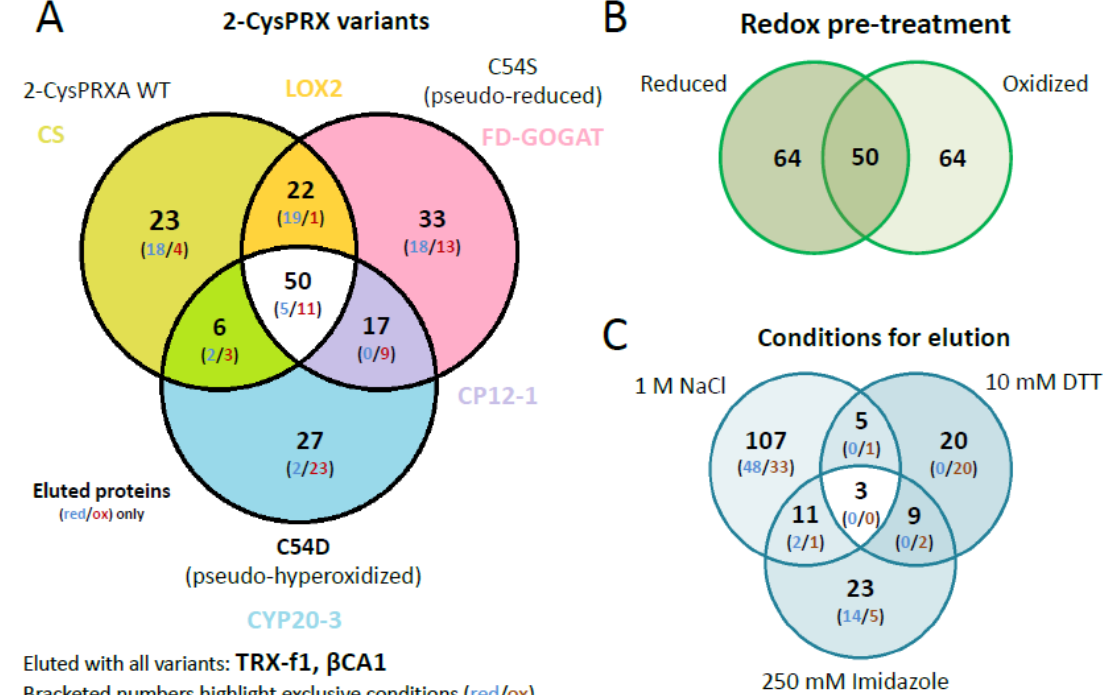
Figure 3. Venn diagrams depicting overlapping and unique 2-CysPRX interactors. ( A ) Comparison of the entire group of interactors of each variant. The set binding to all variants comprised 50 proteins of 178. The group of unique binders to WT, C54S, and C54D consisted of 23, 33, and 27 polypeptides, respectively. ( B ) The compiled groups of redox-specific interactions comprised 64 polypeptides binding under reducing and oxidizing conditions each, and 50 polypeptides binding under both conditions. ( C ) Comparison of the proteins eluted with high salt (NaCl), under reducing conditions (DTT) and as complex with 2-CysPRX by washing with imidazole. The largest group of unique polypeptides eluted with 1 M NaCl and included 107 polypeptides.